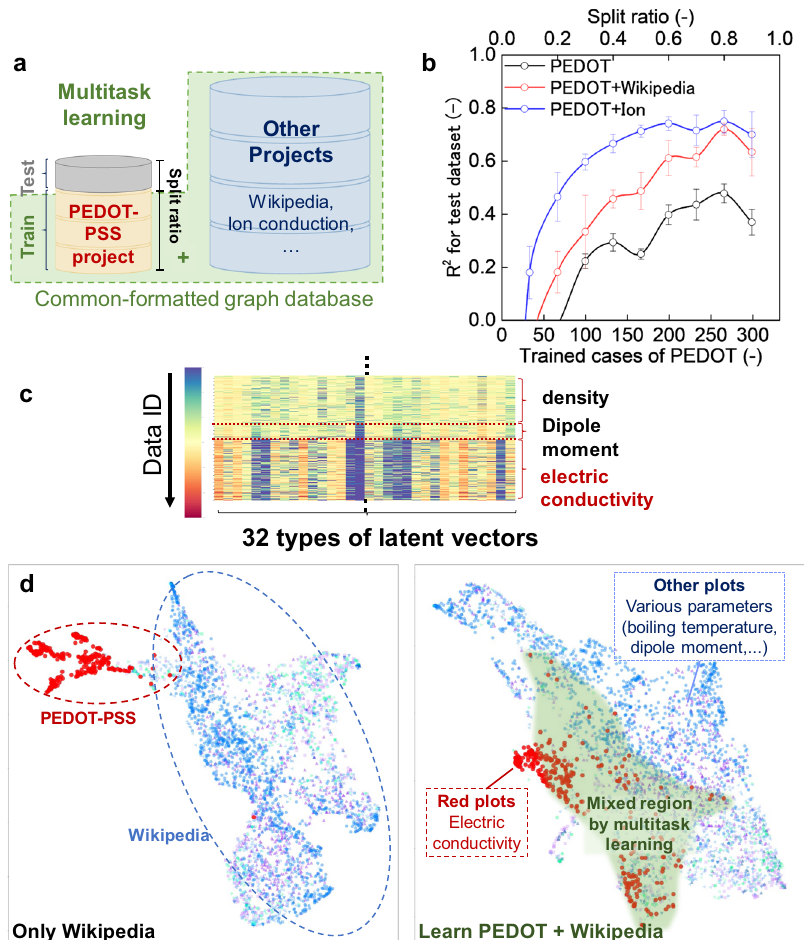
Fig. 4 Multitask learning. a Preparation of datasets for multitask learning. If the split ratio is 0.6, 60% of the randomly selected PEDOT-PSS data and all of the other database are used to train the model. The other 40% is selected as the test dataset. b R 2 scores for the test dataset after multitask learning with Wikipedia or the lithium-ion conducting polymer database. Only the PEDOT-PSS database is trained as a control. The values show the averages of fi ve experiments with different random shuf fl ing ( n = 5 independent experiments). Error bars show the standard errors. See Supplementary Fig. 7 for the results of the training dataset. c Representative heatmap of the latent vectors for the PEDOT-PSS and Wikipedia databases, outputted by a model trained only with the PEDOT-PSS database. See Supplementary Fig. 9 for further information. d Two-dimensional UMAP projection of the latent vectors shown in Supplementary Figs. 9 and